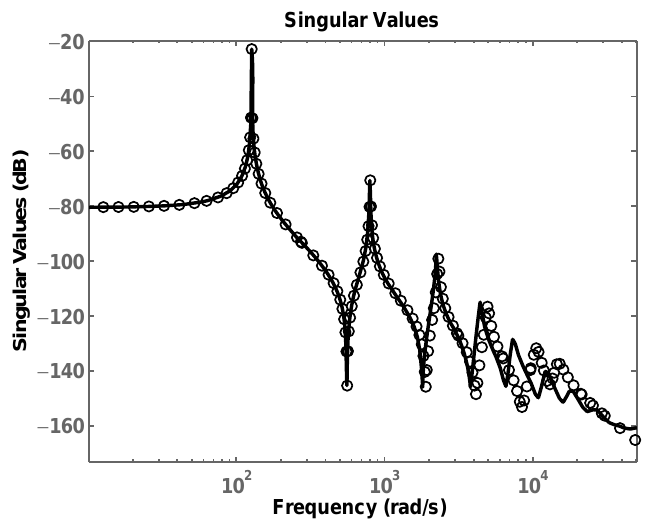
Fig. 5. Singular value diagrams. Solid line – non-reduced model. Circles – reduced